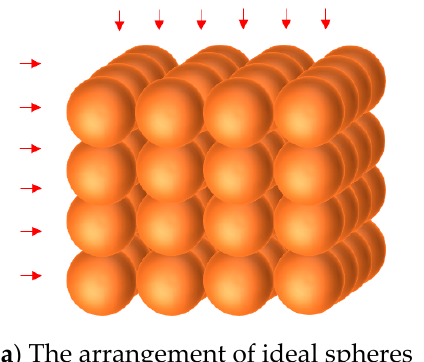
Figure 15. Ideal sphere model of low-grade RA.